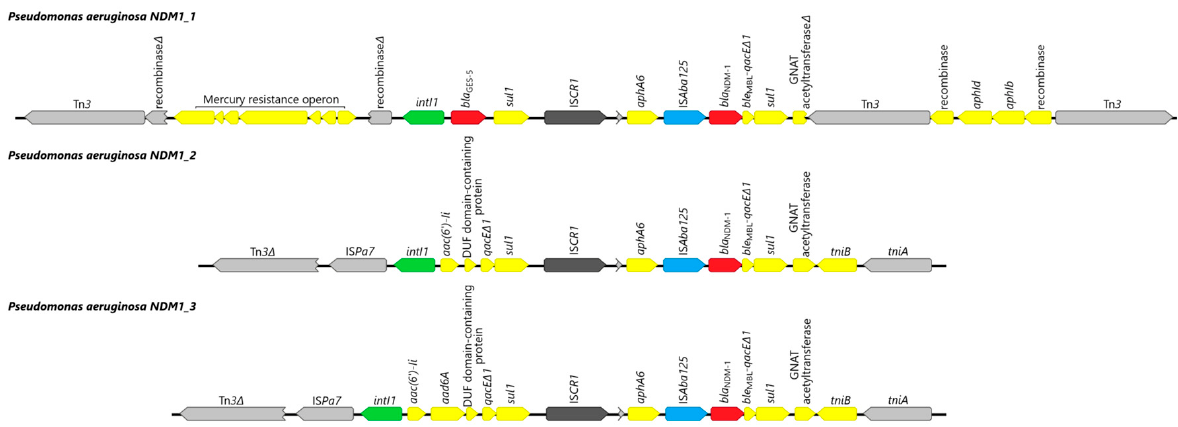
Figure 5. Schematic representation of the bla NDM-1 region in three analyzed Pseudomonas aeruginosa isolates. Δ , an interrupted gene; genes and their transcription orientations are indicated by arrows.